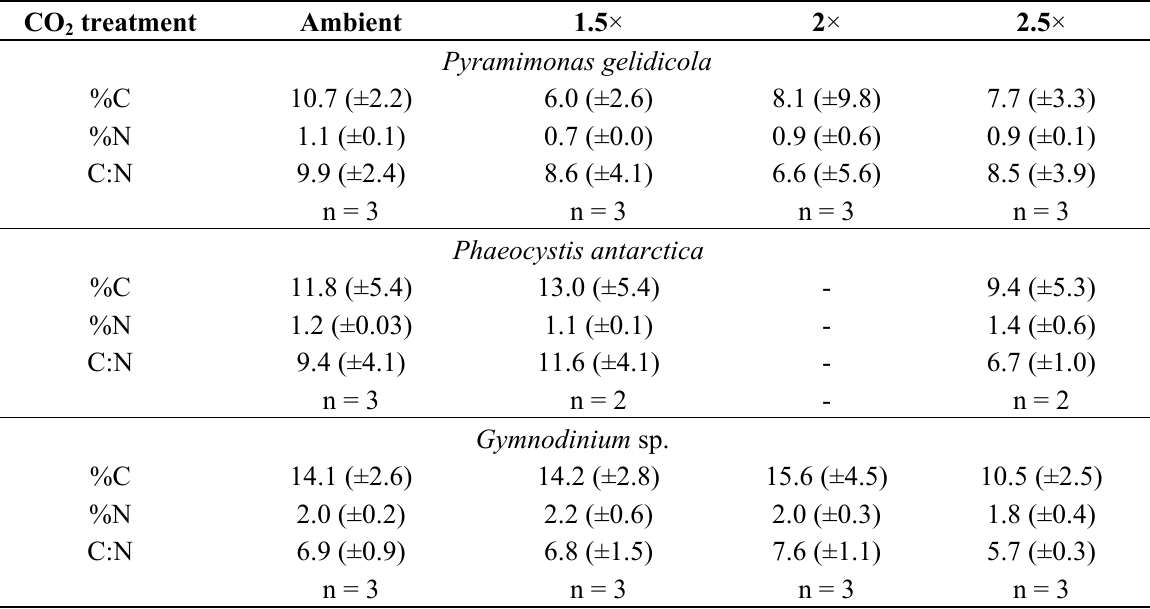
Table 4. Phytoplankton elemental composition of the respective CO Percentages of dry mass, SD in brackets, n = number of